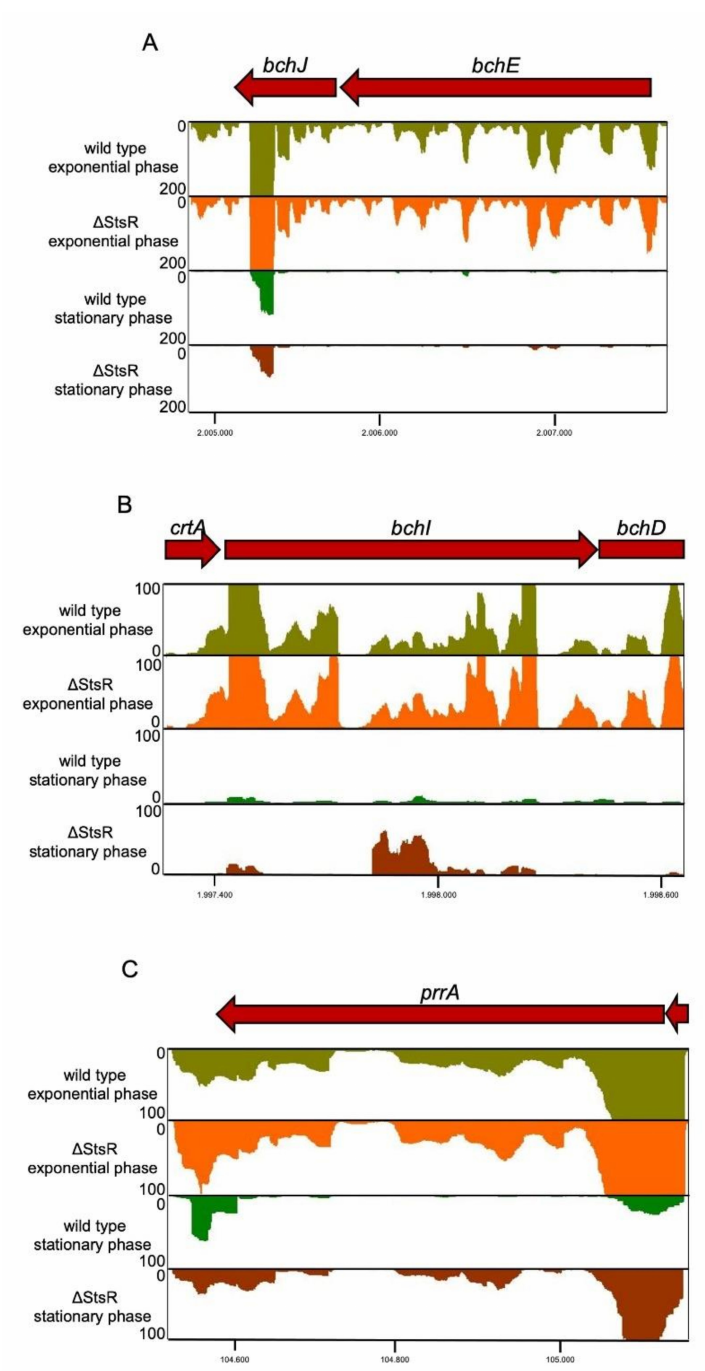
Figure 2. Effect of StsR on expression of selected photosynthesis genes and of the gene for a regulator of photosynthesis genes. Read numbers from RNAseq visualized by the Integrated Genome browser are shown for ( A ) bchJ and bchE genes, ( B ) the bchI gene required for bacteriochlorophyll synthesis and ( C ) the prrA gene encoding the response regulator of the PrrB/PrrA two component system. Reads are shown for RNA isolated from the wild type or a mutant lacking StsR ( ∆ StsR) in the exponential or stationary phase 72 h after inoculation. The read counts within one panel were all normalized to the same scale, as